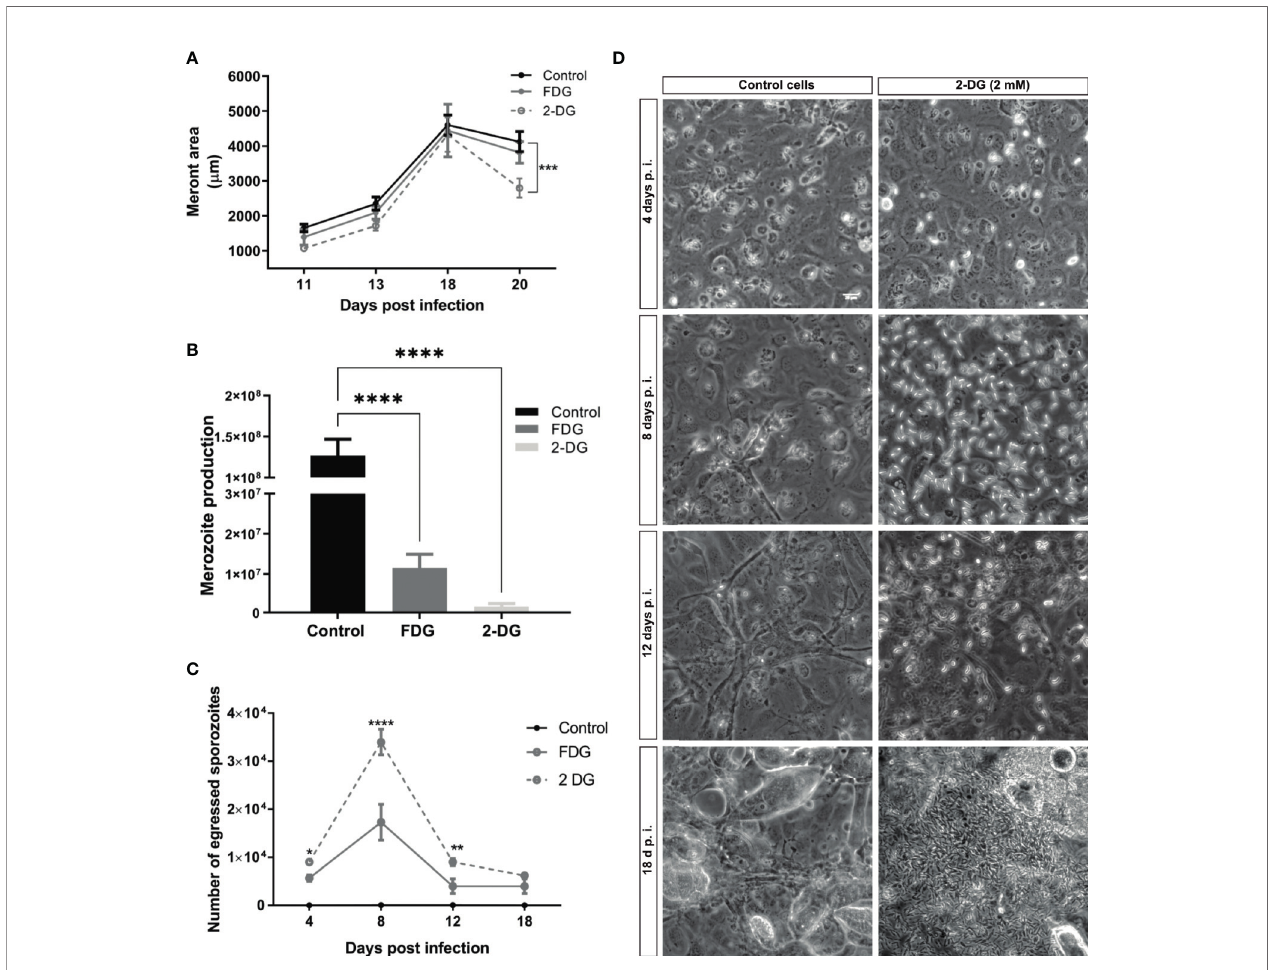
FIGURE 3 | 2-DG and FDG treatments diminish merozoite I production and induce E. bovis sporozoites egress. (A) E. bovis – infected cells (n = 3) were treated with 2 mM 2-DG or FDG from day 8 p. i. onward. As a read-out, the meront area was evaluated at 11, 13, 18, and 20 days p. i. to detect changes in meront growth. (B) At days 18 p. i., supernatants of E. bovis – infected cells treated with 2 mM 2-DG or FDG were analyzed for the presence of merozoites I via EbMIC4-speci fi c qPCR to estimate merozoite I production and release. E. bovis – infected cells lacking any treatment were processed in parallel and served as controls. (C) Analysis of short-term effects of 2-DG or FDG treatments on E. bovis – infected cells. Infected cells were treated at 4, 8, 12 at 18 days p. i. with 2 mM 2-DG or FDG for 2 h. The number of sporozoites released into the cell culture supernatants within 10 min was counted; representative images are illustrated in (D) . Important to notice that the image on (D) for cells treated with 2-DG at 18 d p. i. shows mainly merozoites but not sporozoites releaset to the extracellular space. Statistical analysis applied was a two-way ANOVA with repeated measurements de fi ning the time as the matching variable for A and (C) For B, the statistical test was a multiple comparisons one- way ANOVA (signi fi cance de fi ned as a ≤ 0.05). Values are expressed as means ± SD of three biological replicates. ** p ≤ 0.01, *** p ≤ 0.001, **** p ≤